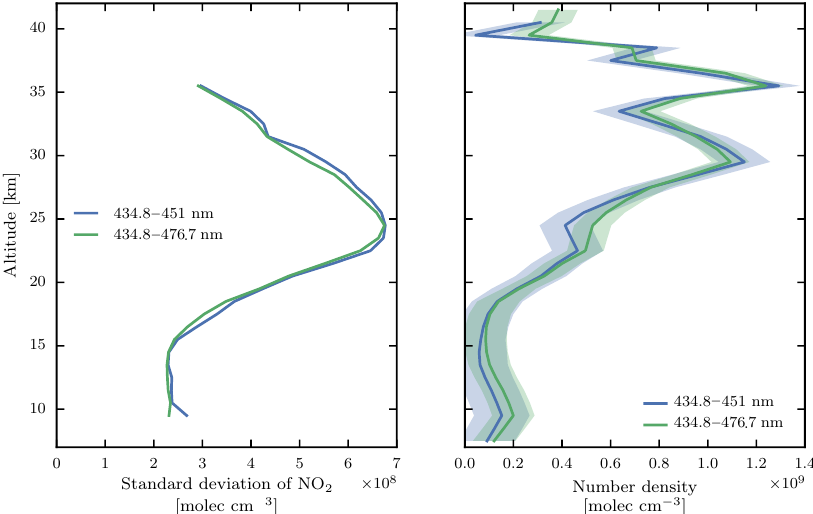
Figure 2. Left: comparison of the standard deviation of the NO 2 number density profiles retrieved with the new algorithm using the de- fault window (435–477nm, green) vs. the fitting window used in the OSIRIS v3.0 operational algorithm (Haley and Brohede, 2007; blue). Right: comparison of a single NO 2 profile retrieved from scan 20 of orbit 60346 with the algorithm described above using the default window (435–477nm) vs. the fitting window used in the OSIRIS v3.0 operational algorithm. The retrieval uncertainty for each profile is bound by a shaded area of matching colour.